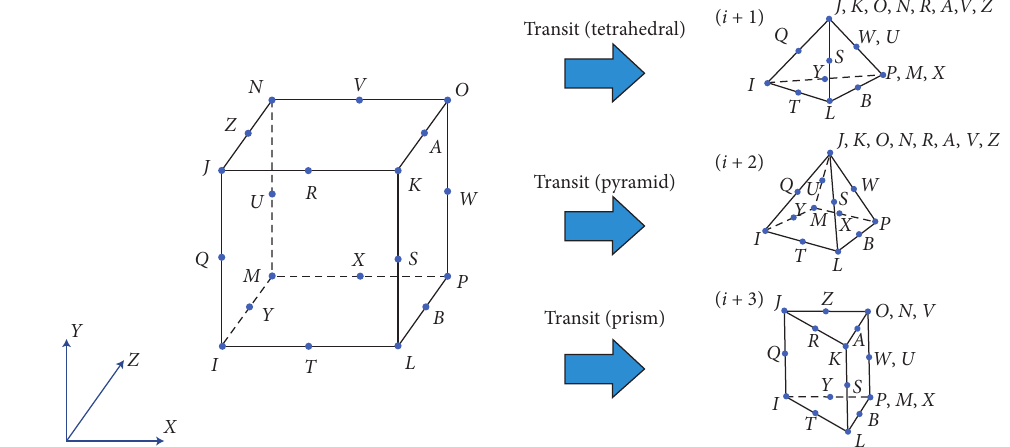
Figure 9: Solid186 elements generated by tetrahedral, pyramid, and prism